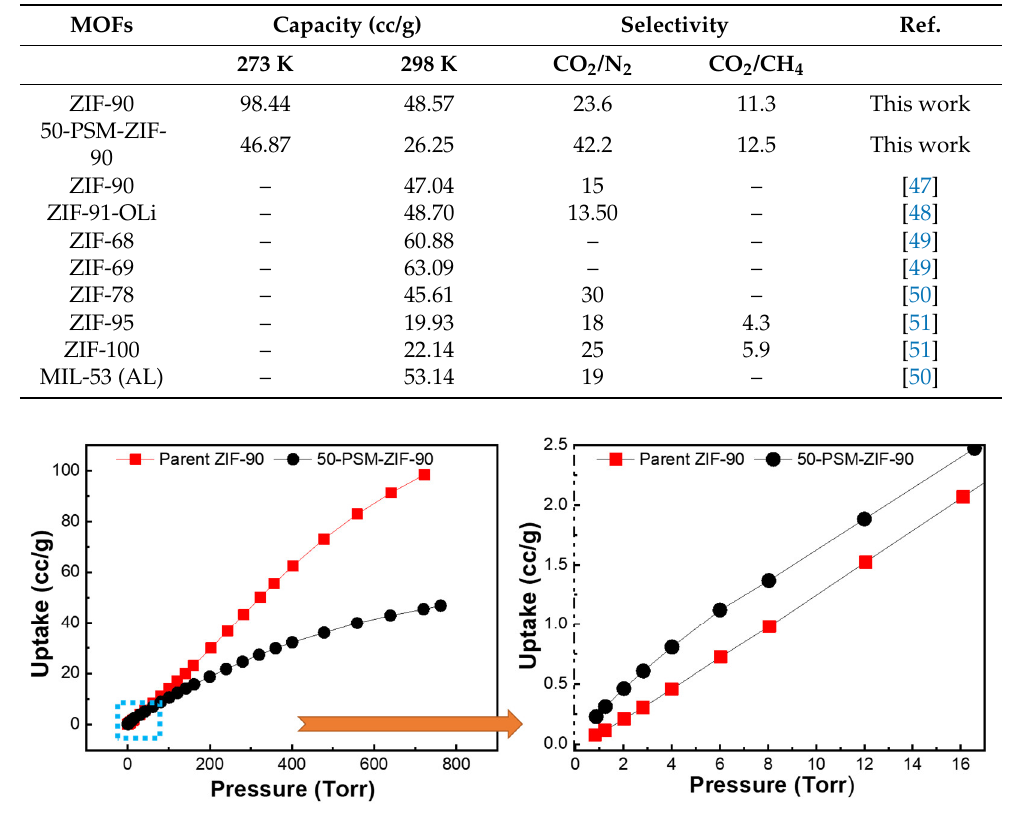
Figure 11. Adsorption isotherms of CO 2 isotherms for ZIF-90 and 50-PSM-ZIF-90 at 273K.